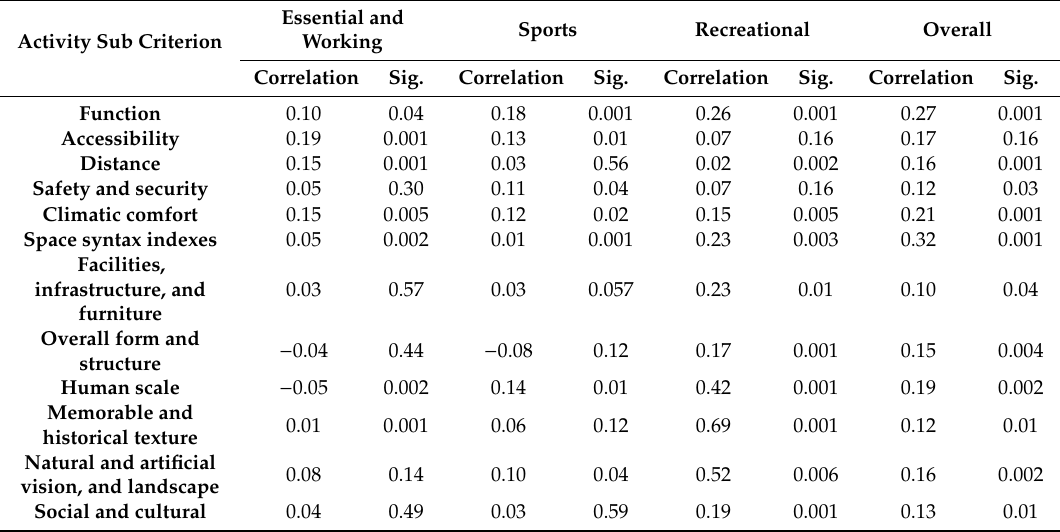
Table 5. Correlation coe ffi cients between the criteria of urban morphology and physical